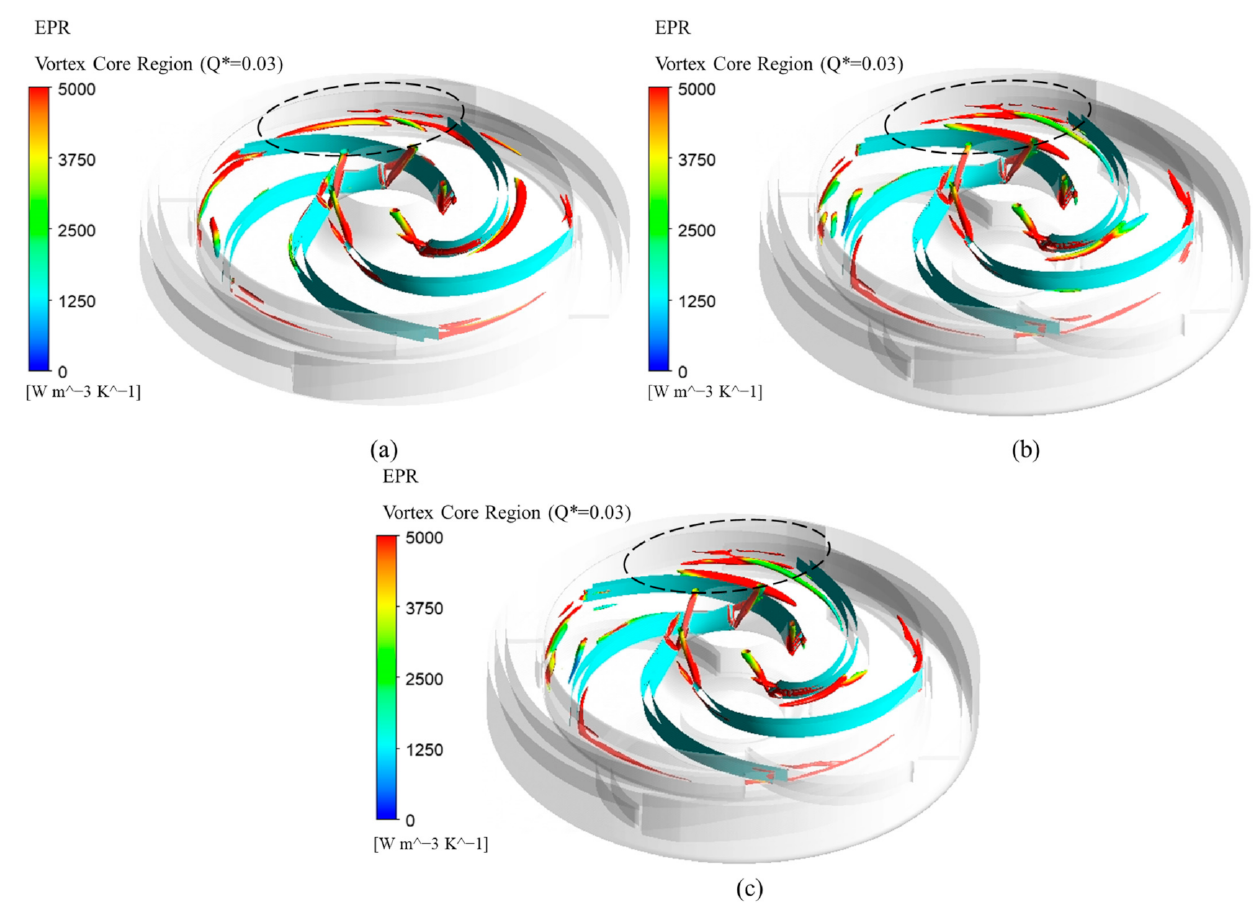
Figure 18. Vortex core distribution of different impellers at 1.0 Q d , where the Q criterion was used with the iso‑surface of Q* = 0.03 and colored by the EGR; ( a ) the first stage, ( b ) the third stage, ( c ) the fifth